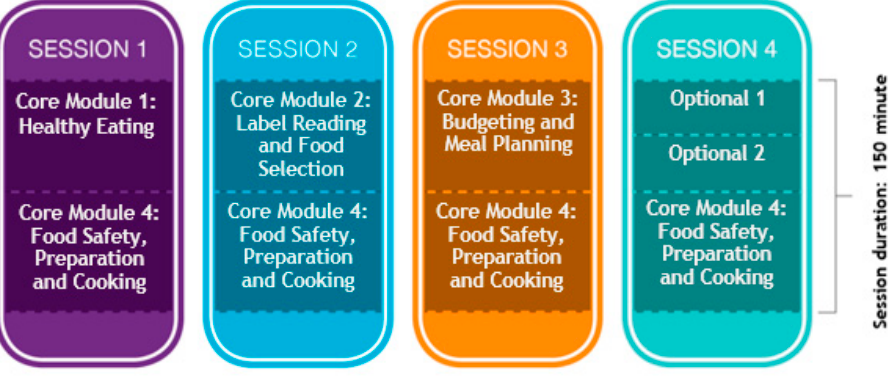
Figure 1. Food Sensations for Adults (FSA) Program Curriculum.